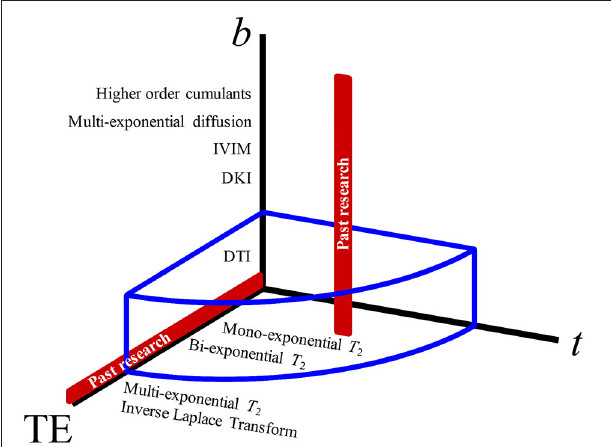
FIGURE 2 | The parameter space of MRI experiments. Varying the b -value (that yields, progressively, diffusion tensor imaging, diffusion kurtosis imaging, intravoxel-inherent motion, multiexponential diffusion, and other signal representations) has been the most popular approach to studying diffusion weighting (red vertical line). Diffusion time, t , giving measurements regarding structural disorder, and echo time, T E , which can be used for altering the compartment weighting, have both been largely unexplored as effects on the diffusion measurements in the prostate. The blue volume surrounding the 3-axes represents the extent of parameter space covered by this